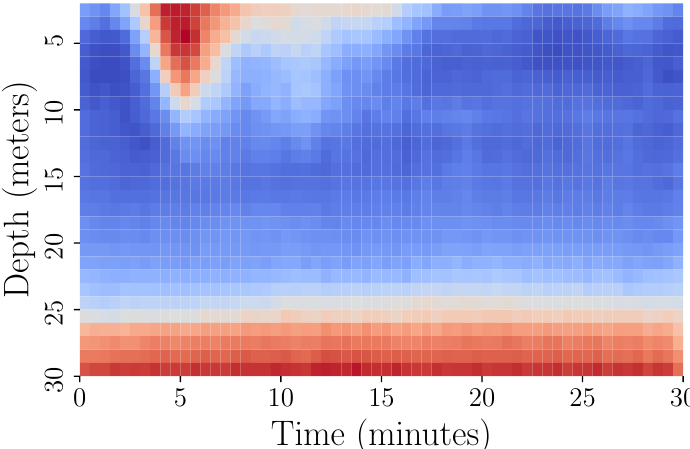
Figure 6. The frame displayed in Figure 4 after being passed through the trained